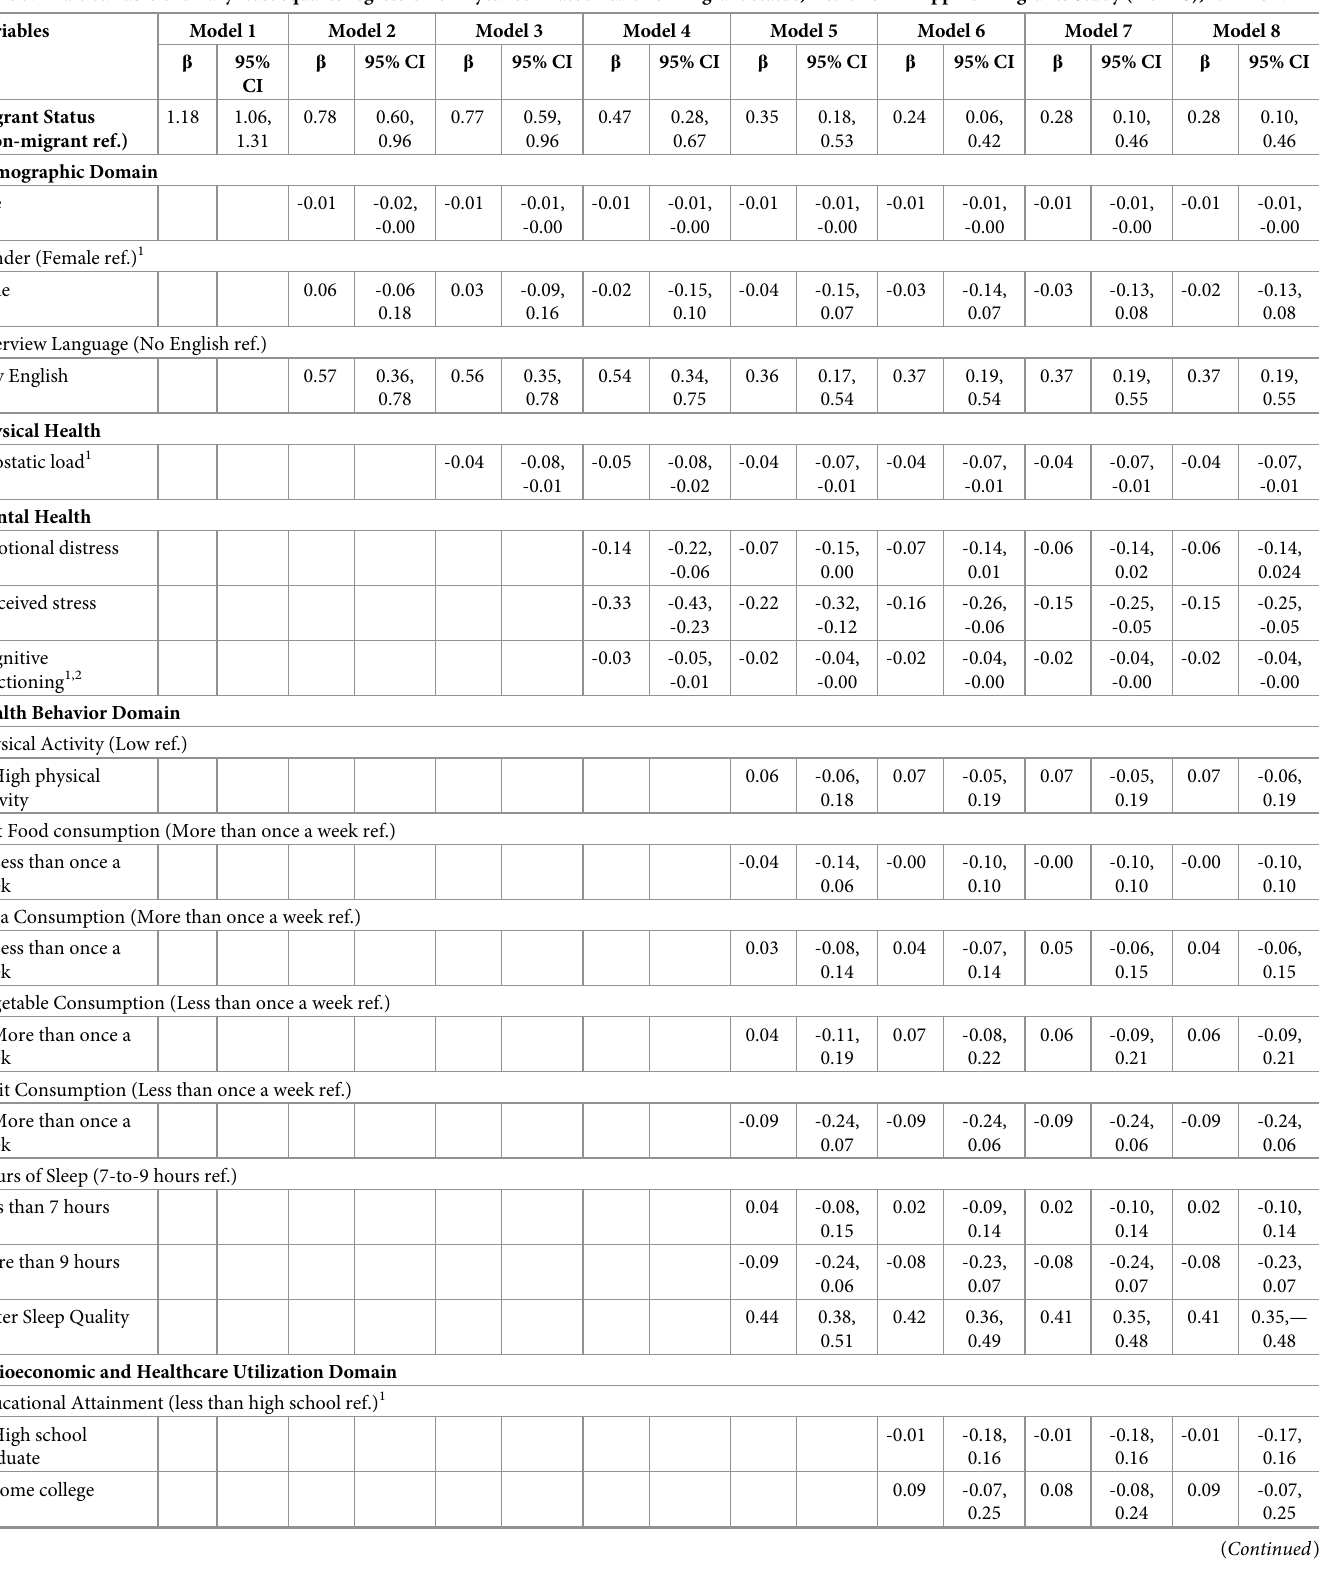
Table 3. Multivariable ordinary least squares regression of 1-year self-rated health on migrant status, Health of Philippine Emigrants Study (HoPES), N =